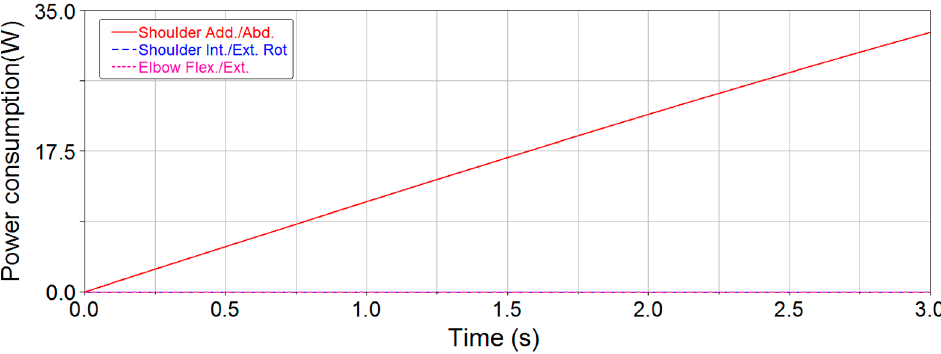
Figure 17. Joint power consumption curves of lateral lifting for the 5 ‐ DOF exoskeleton.